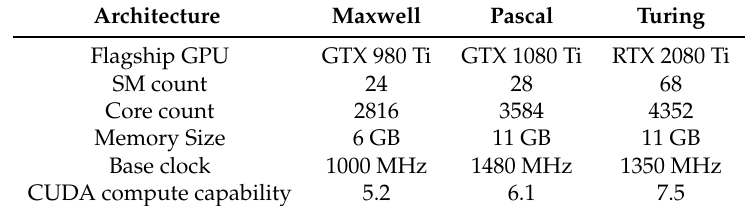
Table 6. Features of the latest Nvidia graphics processing units (GPU) architectures.